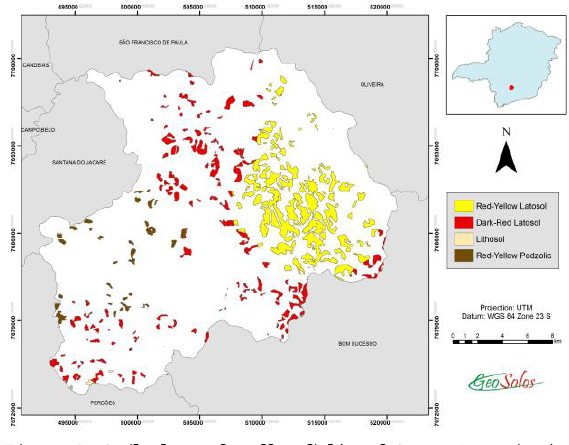
Figure 6. Soil class of coffee fields of Santo Antonio do Amparo, Minas Gerais,